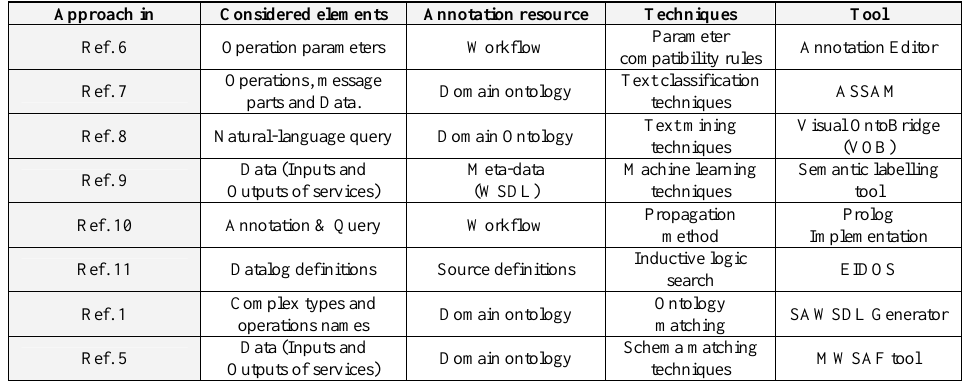
Table 1. Summary of the Web service annotation